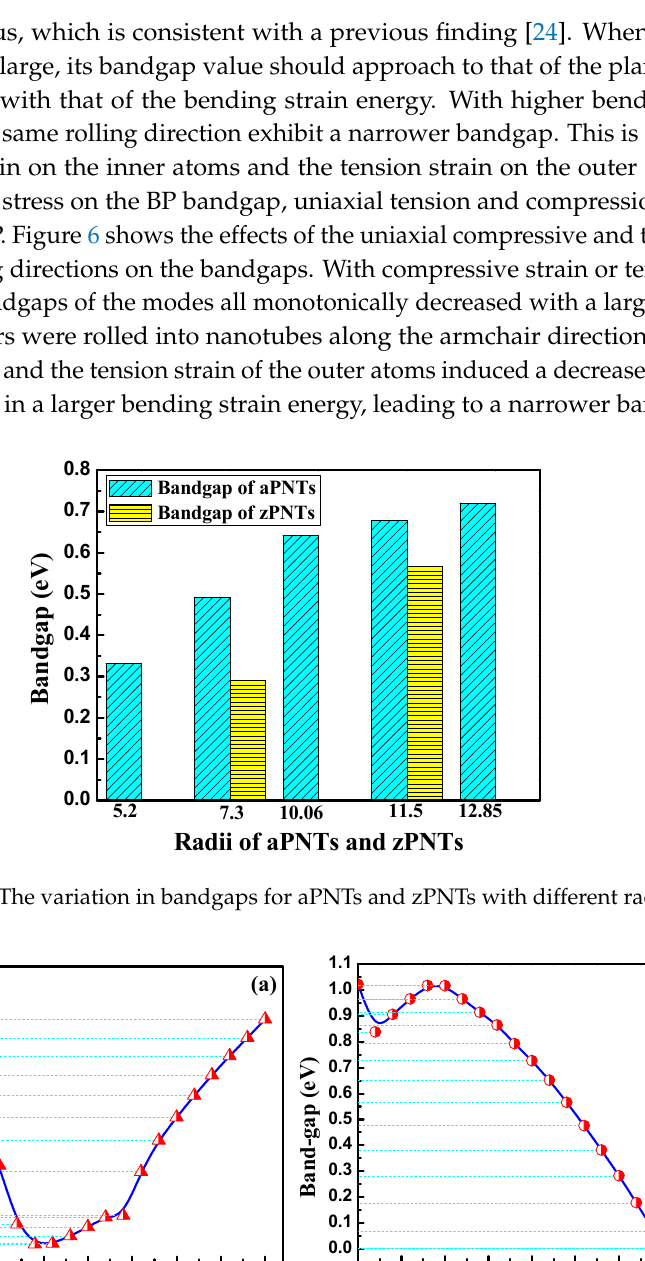
Figure 6. Band-gaps of monolayer phosphorus under different uniaxial compressive and tensile stresses along ( a ) zigzag and ( b ) armchair directions.